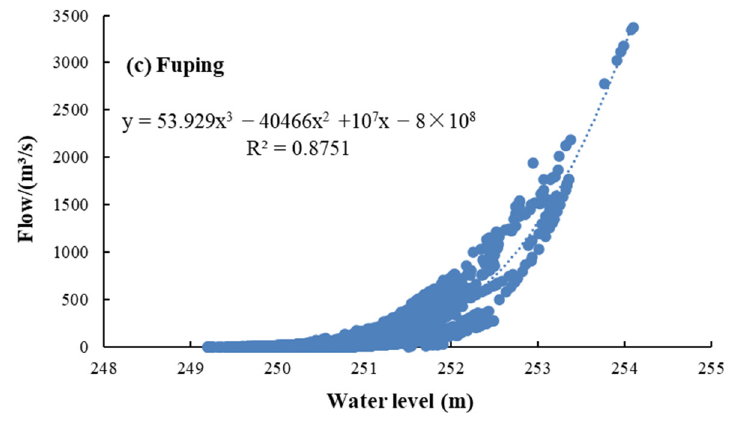
Figure 7. Relationship between water level and flow.